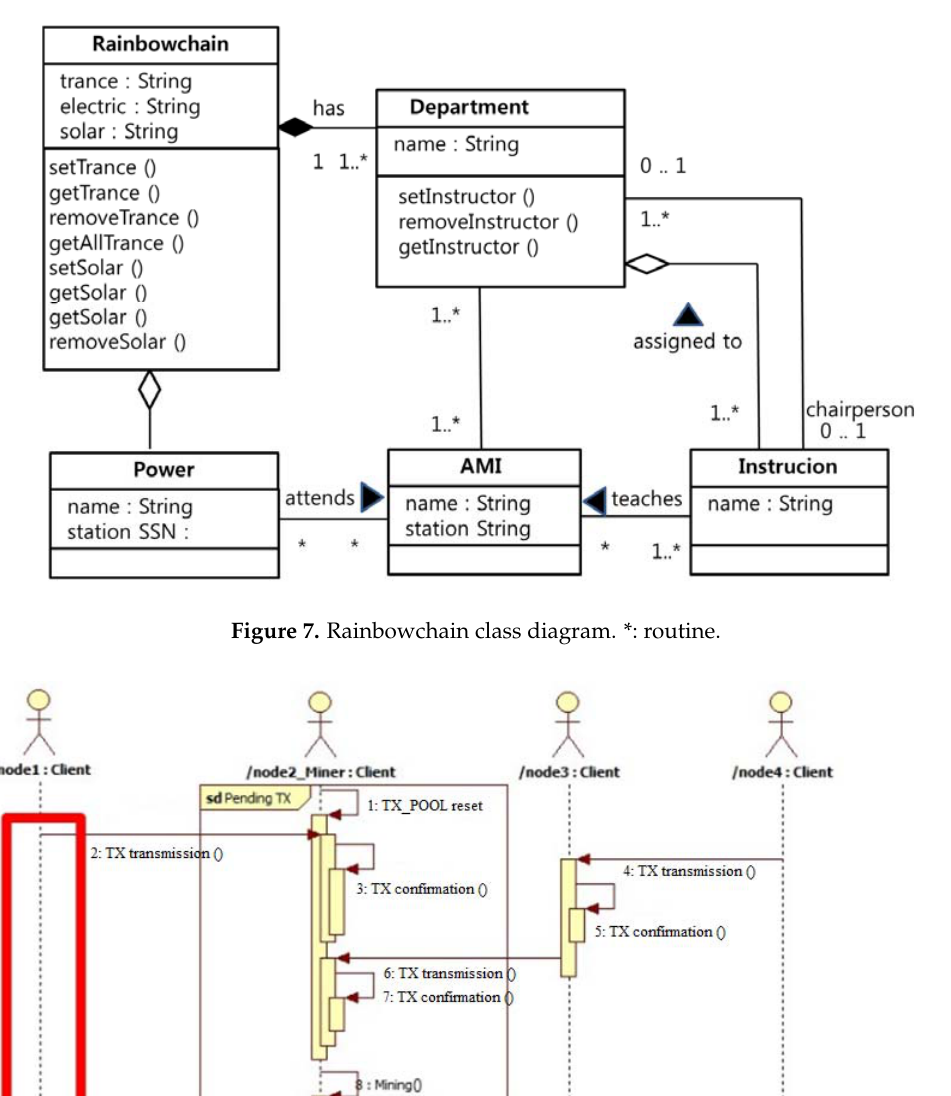
Figure 6. Rainbowchain use ‐ case diagram.